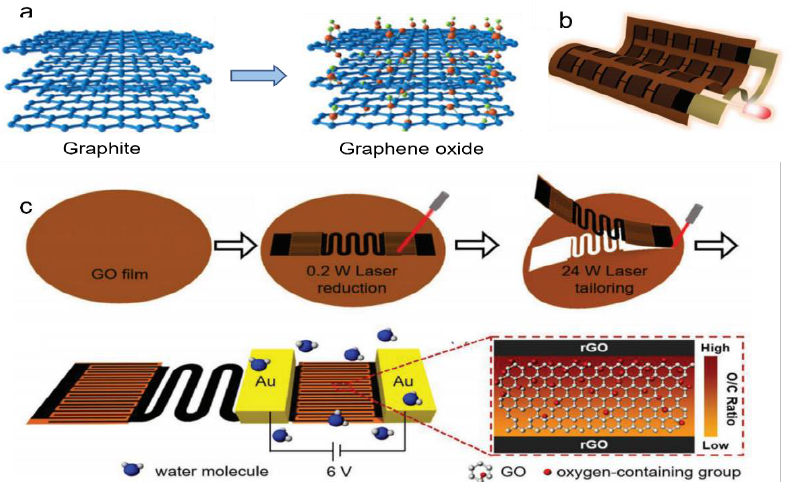
Figure 6. Electricity generation from graphene materials with instantaneous output. ( a ) Synthesis of GO from graphite through Hummers’ method. There are many oxygen functional groups on sheets of GO due to the strong oxidization of graphite. Reprinted with permission from Ref. [80]. Copyright 2018 American Association for Joural of Physics D-Applied Physics; ( b ) A large-scale, rollable HEG integration. ( c ) Schematic drawing of GHEG preparation. GO film and rGO interdigital electrodes and circuits that were in situ were reduced by direct laser writing. A pair of gold electrodes was physically pressed on rGO electrodes of GHEG and applied with a 6 V bias under a high-humidity environment. The oxygen-containing group distribution between the electrodes after the polarization process, which shows a concentration difference. Reprinted with permission from Ref. [82].